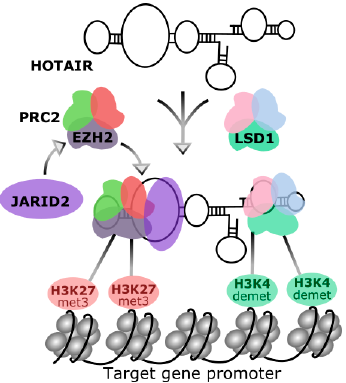
Figure 2. Chemical modifications of chromatin directed by HOTAIR. HOTAIR recruits polycomb repressive complex 2 (PRC2), containing the histone methyltransferase EZH2 (enhancer of zeste 2 polycomb repressive complex 2 subunit), which is activated by JARID2 (Jumonji and AT-rich interaction domain containing 2). Active EZH2 (enhancer of zeste 2 polycomb repressive complex 2 subunit) trimethylates H3 histone at lysine 27 (H3K27met3) bound to the target gene. On the other hand, HOTAIR interact with LSD1 (lysine specific demethylase 1A), a histone demethylase, which is a part of larger protein complex and demethylases H3 histone at lysine 4 (H3K4demet). These chemical modifications of histone tails lead to chromatin complexing and silencing of the transcription of target